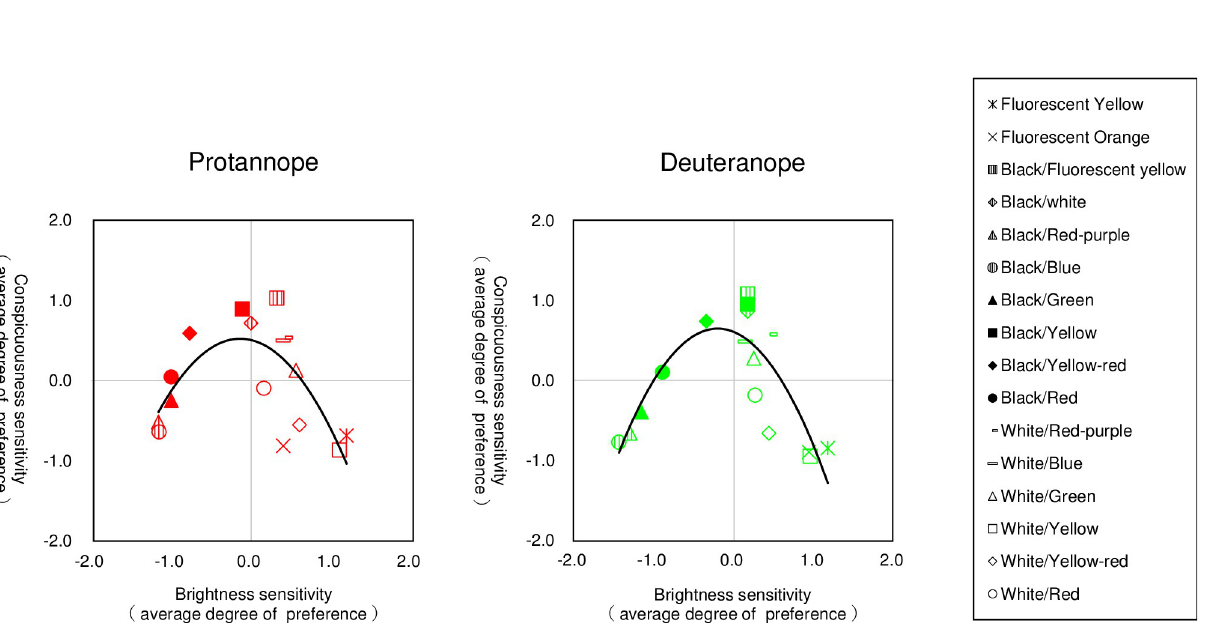
PLOS ONE | https://doi.org/10.1371/journal.pone.0274824 September 16,